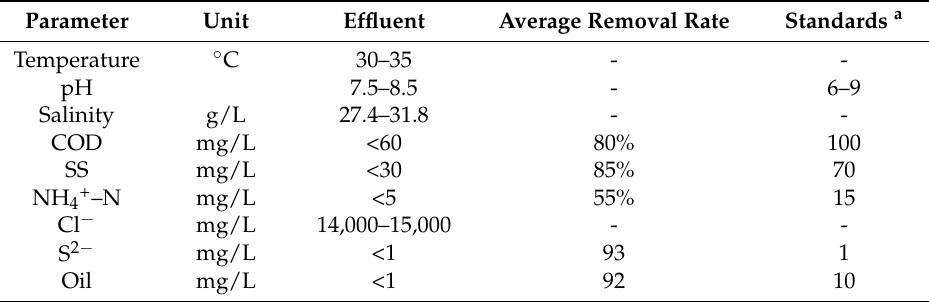
Figure 5. Biochemical oxygen demand over a five-day test (BOD 5 ) change during ABR pretreatment. Table 2. Composition of treated WORS by